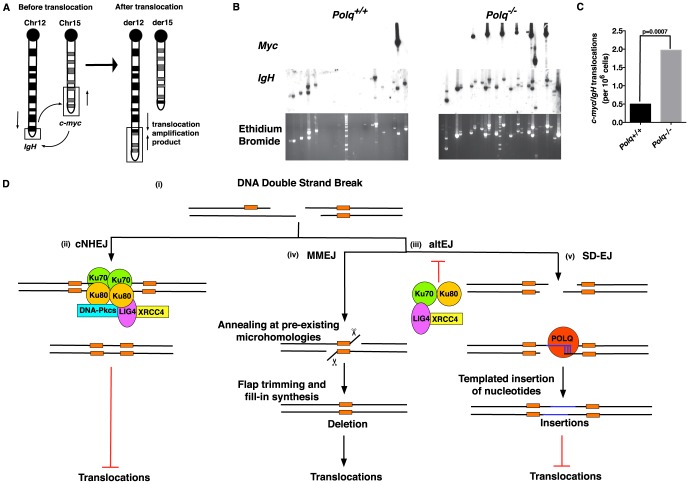
POLQ suppresses chromosomal translocation in vivo.(A) Representative schematic for the Myc/IgH translocation assay. PCR amplification primers are represented by black arrows. Closed circles denote centromeric locations on the chromosomes. Naïve B cells from wild-type (WT) or Polq−/− mice were assayed for translocations after 72 hr in culture. (B) Representative agarose gels stained with ethidium bromide and Southern blots with IgH and Myc probes. Each lane contains the DNA content of 1×105 genomes. Three independent experiments were performed. (C) Frequency of translocations was plotted and p-values determined using two-tailed Fisher's exact test. Frequencies were calculated from total translocations (Polq+/+: 5; Polq−/−: 17) divided by total number of genomes surveyed (9.6×106). (D) Model of end joining-mediated repair of DNA double-strand breaks (DSBs). (i) Schematic representing a DSB with existing microhomologies shown in orange. (ii) DSBs are preferentially processed by classical non-homologous end joining (cNHEJ), dependent upon Ku70–80 and Ligase4-XRCC4. This pathway is not thought to promote DNA translocations. In the absence or impairment of critical cNHEJ factors (iii) alternative end joining (altEJ) pathways are utilized. These pathways appear to be suppressed by Ku70–80 and Ligase4-XRCC4. The MMEJ pathway (iv) can orchestrate annealing of ends at pre-existing microhomologies (2–5 bp) resulting in a net deletion of genomic information. Utilization of this pathway can enhance the formation of chromosomal translocations. In the SD-EJ pathway (v) POLQ can catalyze extension of minimally paired 3′ single-stranded DNA ends (shown in blue) to facilitate end joining and suppress the formation of chromosomal translocations.